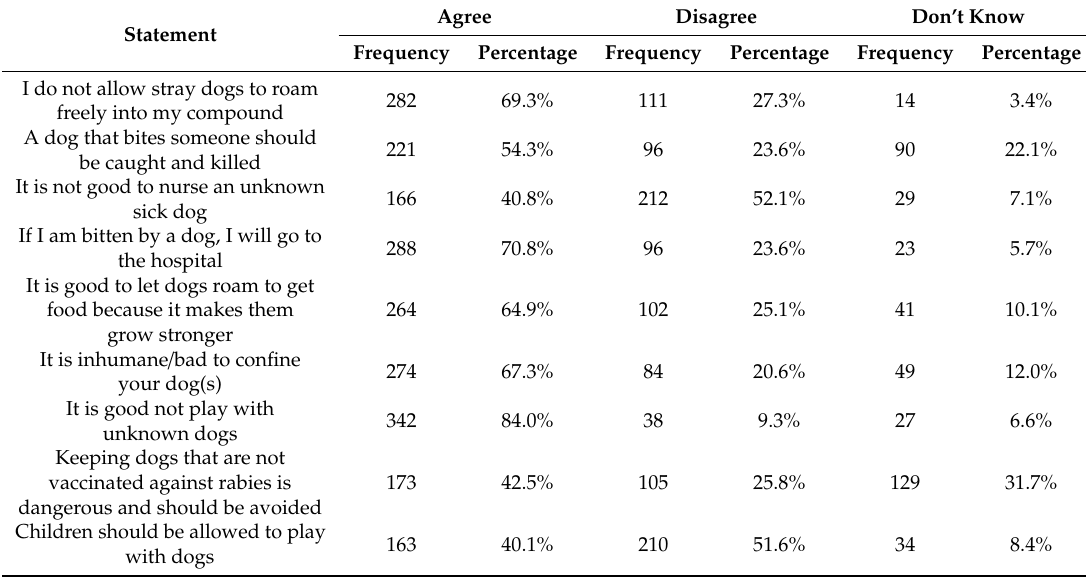
Table 3. Attitudes of study participants.